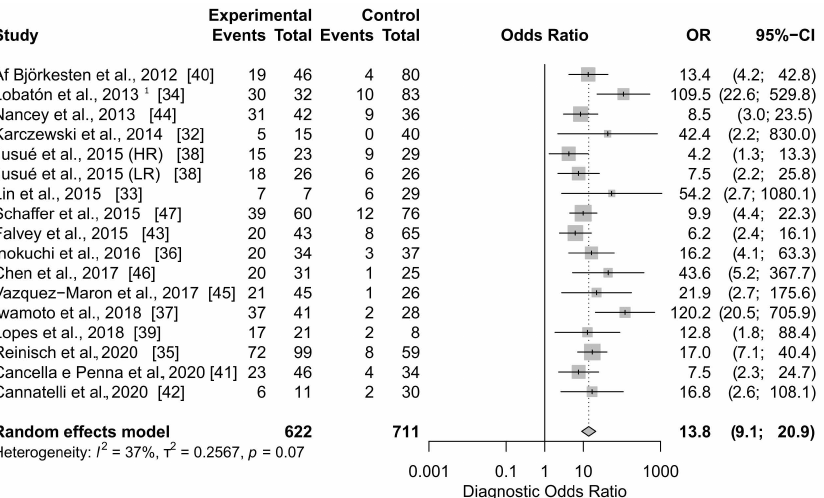
Figure 1. Forest plot of Diagnostic Odds Ratio calculated for the use of FC as the biomarker of mucosal healing in Crohn’s disease. Abbreviations: CI, confidence interval; OR, odds ratio. Notes: Jusu é et al. compared High Range (HR) and Low Range (LR) Quantum Blue rapid kits; 1 ELISA